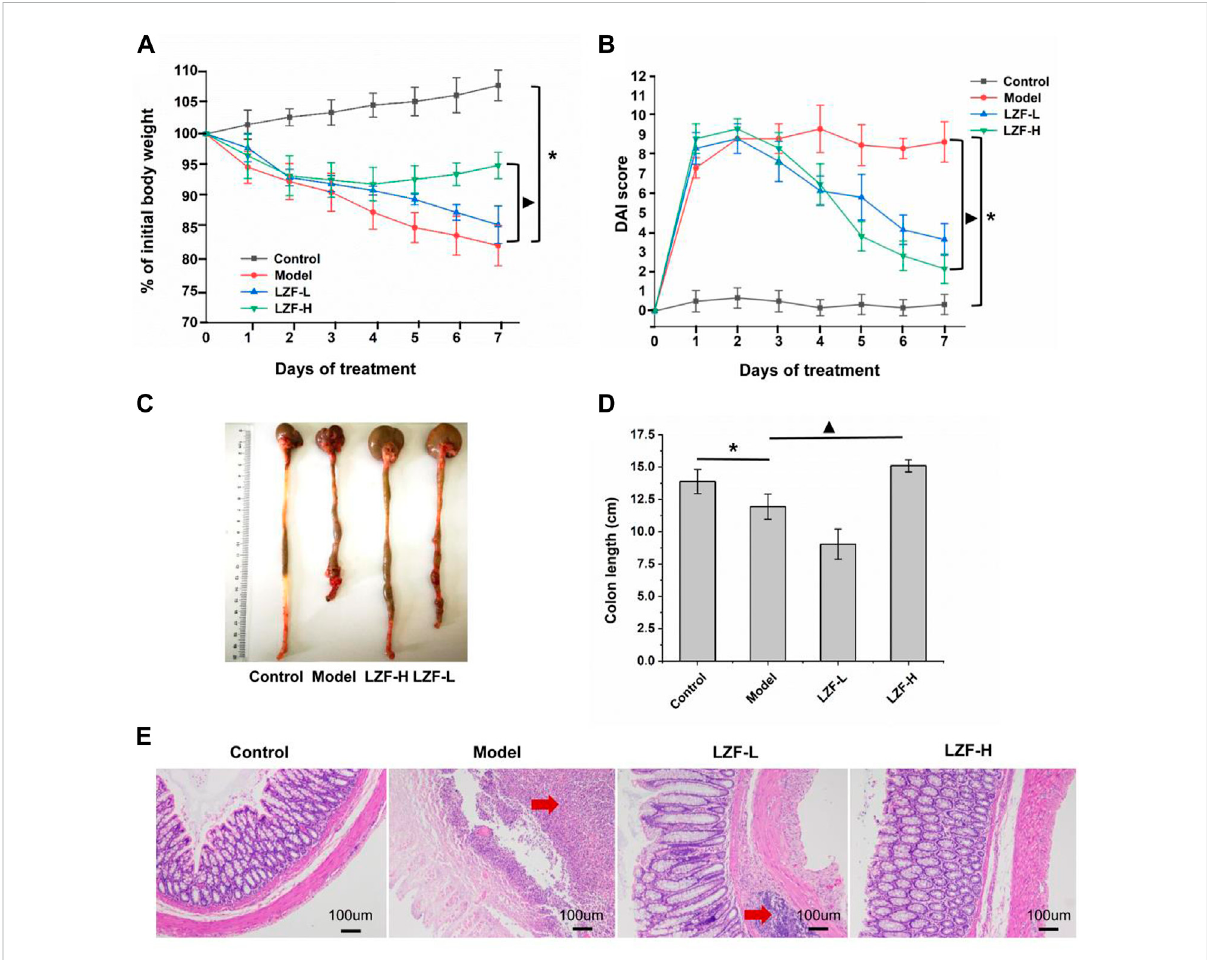
TherapeuticeffectofLZFsolutiononulcerativecolitiscausedbyTNBS. (A) Bodyweight; (B) DAIscore; (C) colonimage; (D) colonlength;and (E) histopathological section of